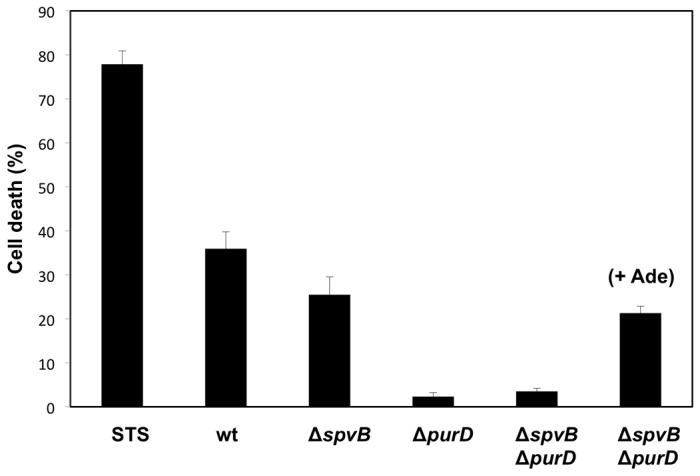
Cytotoxicity of purD mutant on HeLa
cells 24 h post-infection. The cell death induction capacity of Salmonella strains was measured by the LDH release method. Staurosporine (STS) was used as a positive control for cell death. All samples were compared with the level of spontaneous cell death in non-infected cells. The results are the mean ± SD of three independent experiments. Culture medium was supplemented for two hours with normal adenine concentration and then was replaced by a low adenine concentration medium, except the sample on the right, which was supplemented with normal adenine concentration (+Ade). The multiplicity of infection was 100:1.